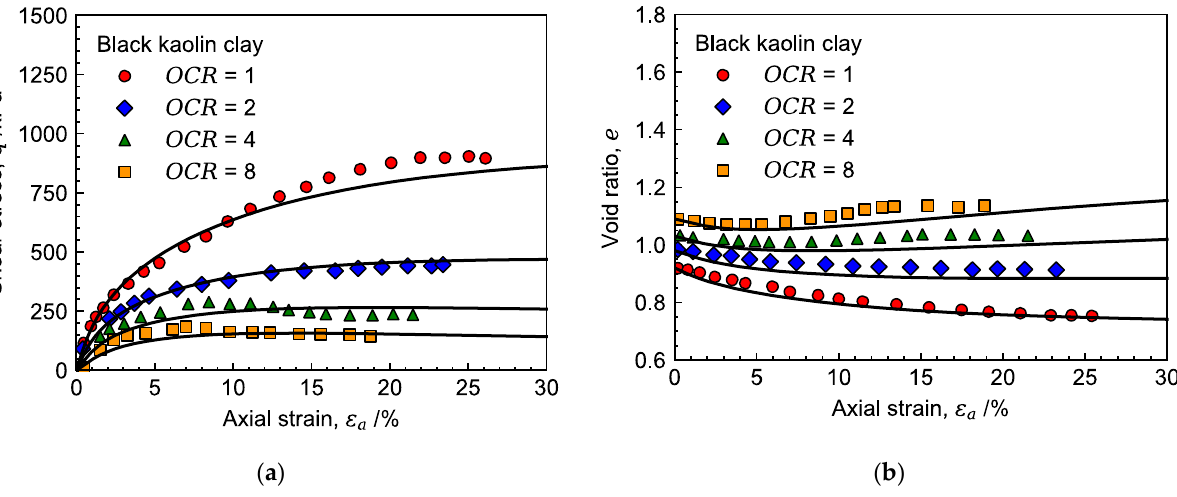
Figure 8. Measured and predicted drained triaxial test results of black Kaolin clay: ( a ) the shear stress–axial strain relation; ( b ) the void ratio–axial strain relation.